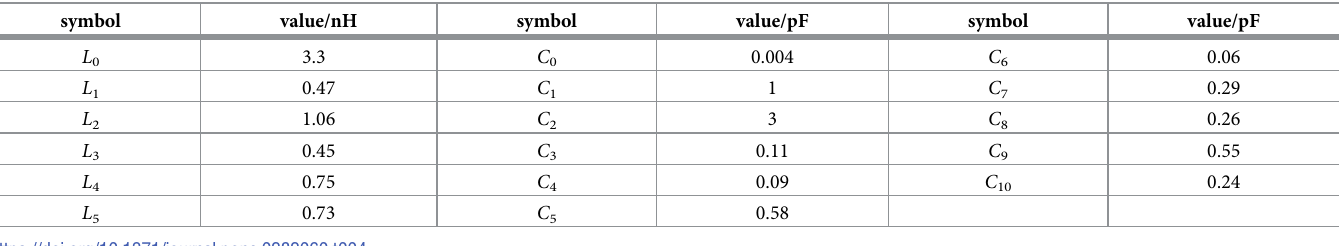
1 ffiffiffiffiffiffiffiffiffiffiffiffiffiffiffiffiffiffiffiffiffiffiffiffi p ð 24 Þ 2 p ð C þ C Þ L 5 6 7